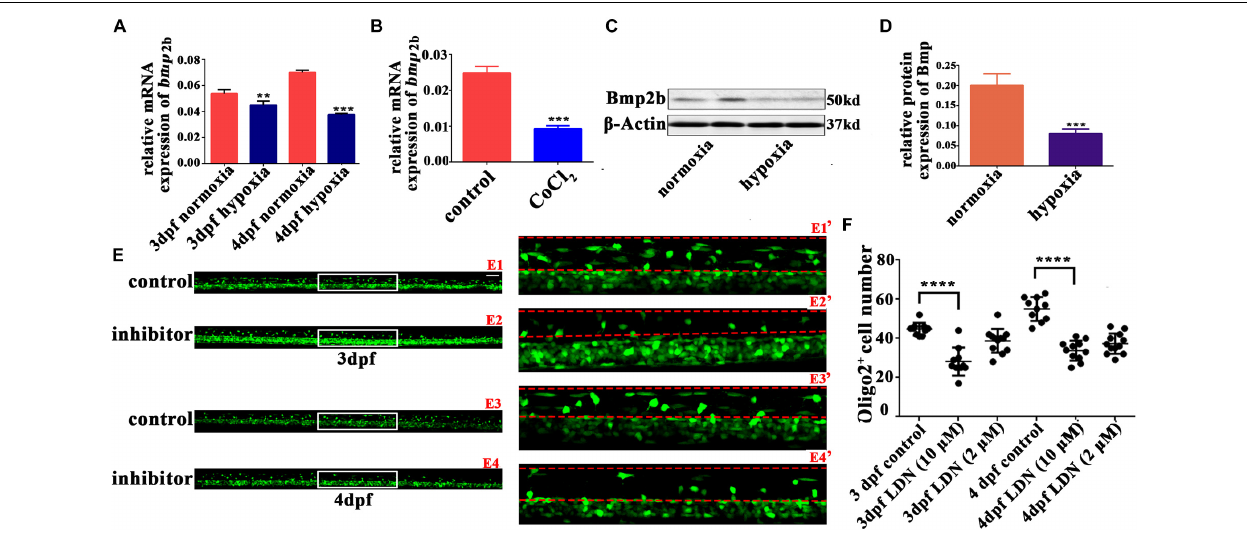
FIGURE 4 | The Bmp2b inhibitor suppresses OPC migration to the dorsal area. (A,B) qRT-PCR analysis indicated that bmp2b gene mRNA expression was significantly downregulated after hypoxia and CoCl 2 exposure. (C,D) Bmp2b protein expression was analyzed with western blots. The results showed that hypoxia blocked Bmp2b protein translation. Thirty zebrafish 4-dpf larvae were pooled for western blots experiments. (E,F) The number of dorsally migrated olig2 + cells at 3 and 4 dpf decreased after LDN193189 treatment. E1 (cid:48) , E2 (cid:48) , E3 (cid:48) , and E4 (cid:48) are magnified pictures of the white boxes in E1, E2, E3, and E4. Scale bars: E1–E4, 50 µ m and E1 (cid:48) –E4 (cid:48) , 10 µ m. Two-way ANOVA, P < 0.0001: Student’s two-tailed t -test. Significantly more cells were dorsally migrated in 3-dpf control larvae as compared to 3-dpf larvae treated with 10 µ M LDN193189 ( n = 12; P < 0.0001). Significantly more cells were dorsally migrated in 4-dpf normoxic larvae as compared to 4-dpf